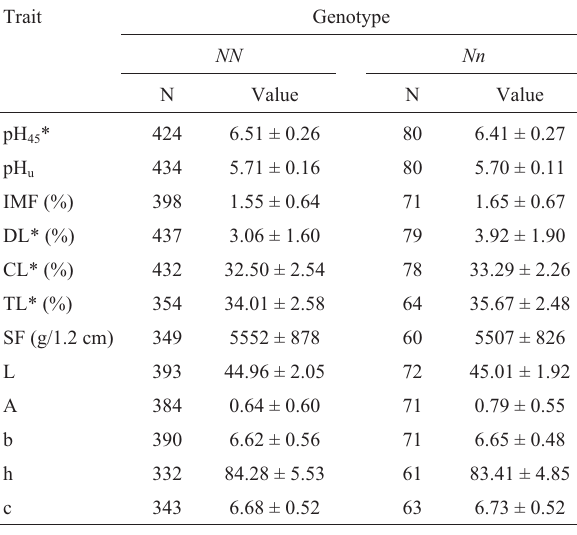
Table 1 - Pork quality traits for each PSS genotype ( NN and Nn ).